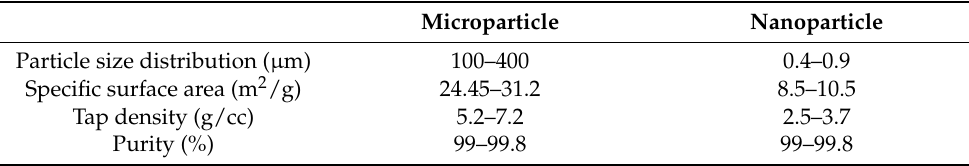
Table 1. Shielding-material particle-processing